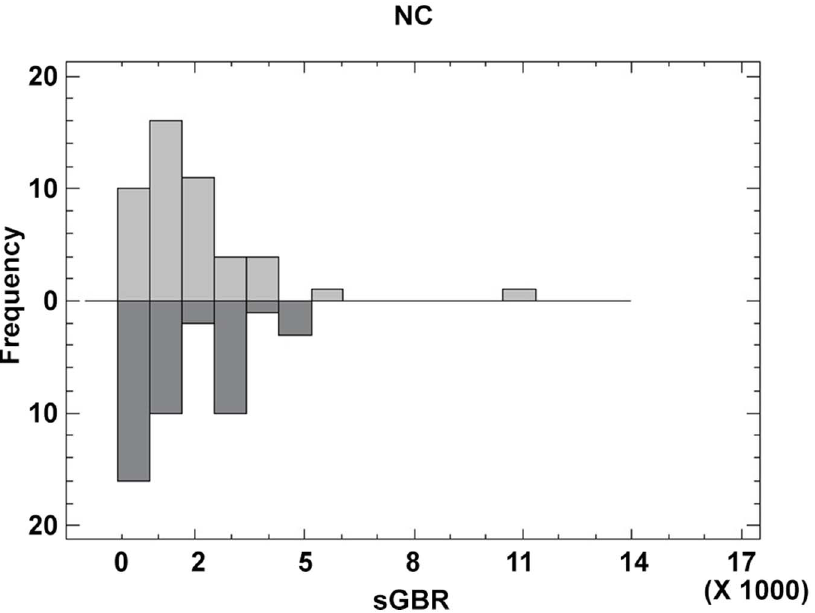
Figure 3. Mean time (days) from initial tagging locations in the Coral Sea. sGBR (n=31) and NC (n=58).